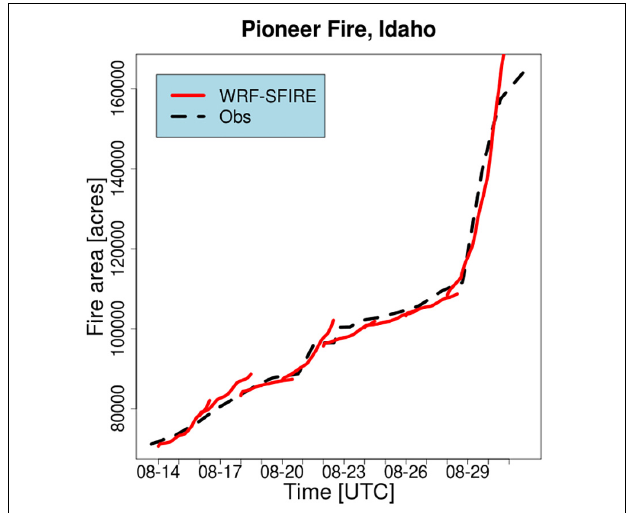
FIGURE 5 | Observed vs. WRF-SFIRE predicted fire area for the Pioneer Fire in August 2016.